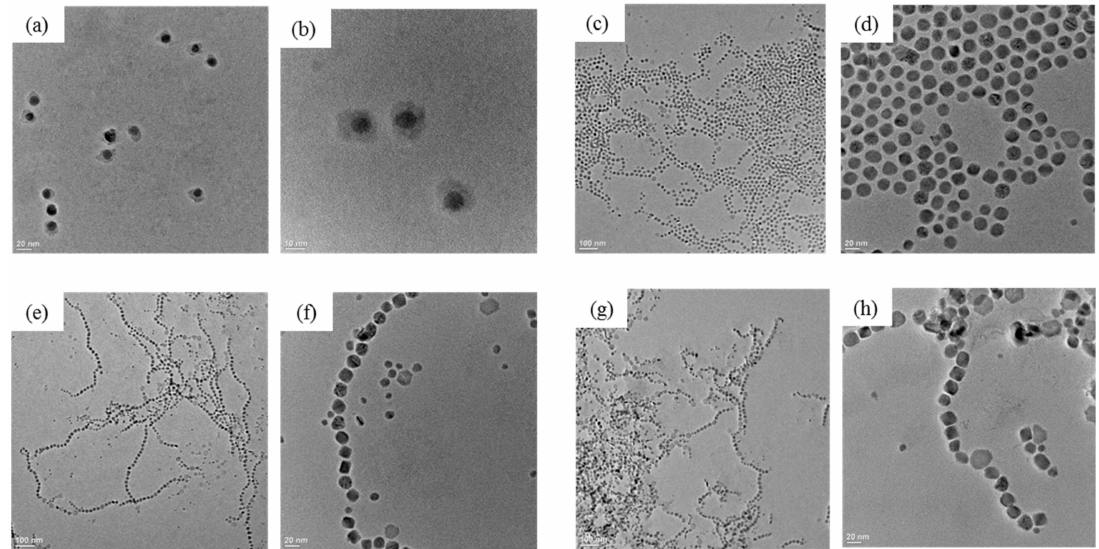
Figure 2. TEM images of PS-Co NPs synthesized with the concentration of cobalt carbonyl fixed at 21.9 mM, and with different concentration of PS–NH 2 ( M n = 2300 g/mol, C PS ): ( a , b ) C PS = 5 mM, D = 12.0 ± 1.9 nm; ( c , d ) C PS = 2.5 mM, D = 20.7 ± 1.3 nm; ( e , f ) C PS = 1.25 mM, D = 17.8 ± 2.1 nm; ( g , h ) C PS = 0.63 mM, D = 19.7 nm ± 3.3 nm. The PS–Co NP samples were prepared on TEM grids from respective Co NP dispersion in DCB. The mean size and standard deviation were obtained from a sample of around 200 NPs using ImageJ software.